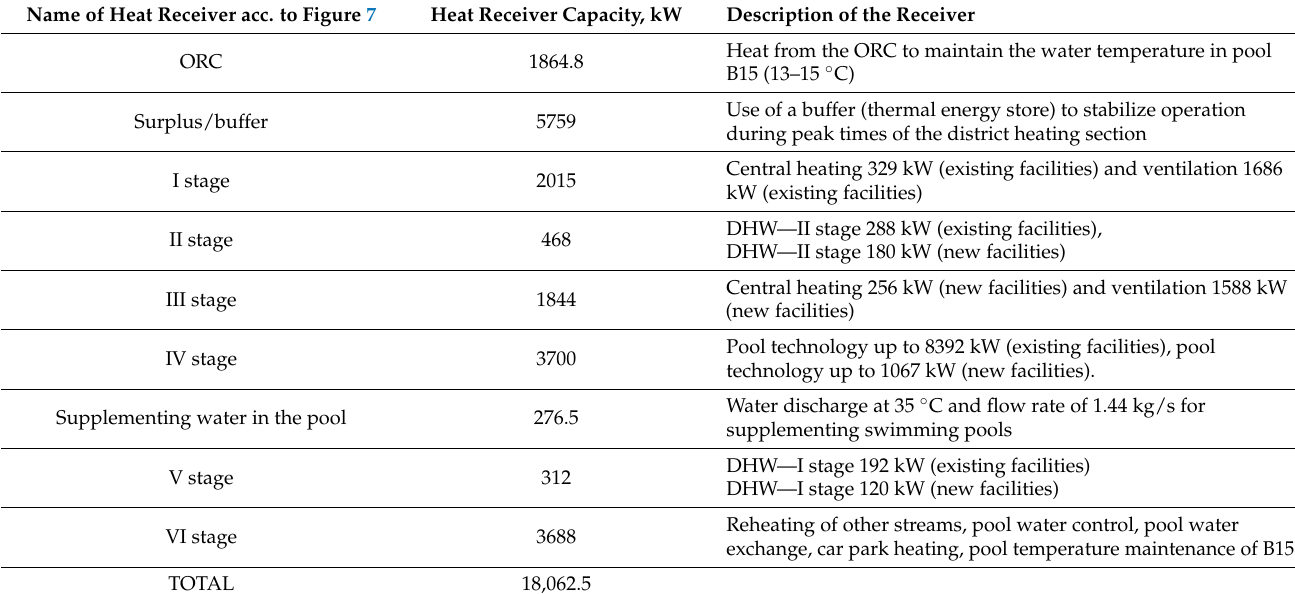
Table 6. Characteristics of the equipment selected.